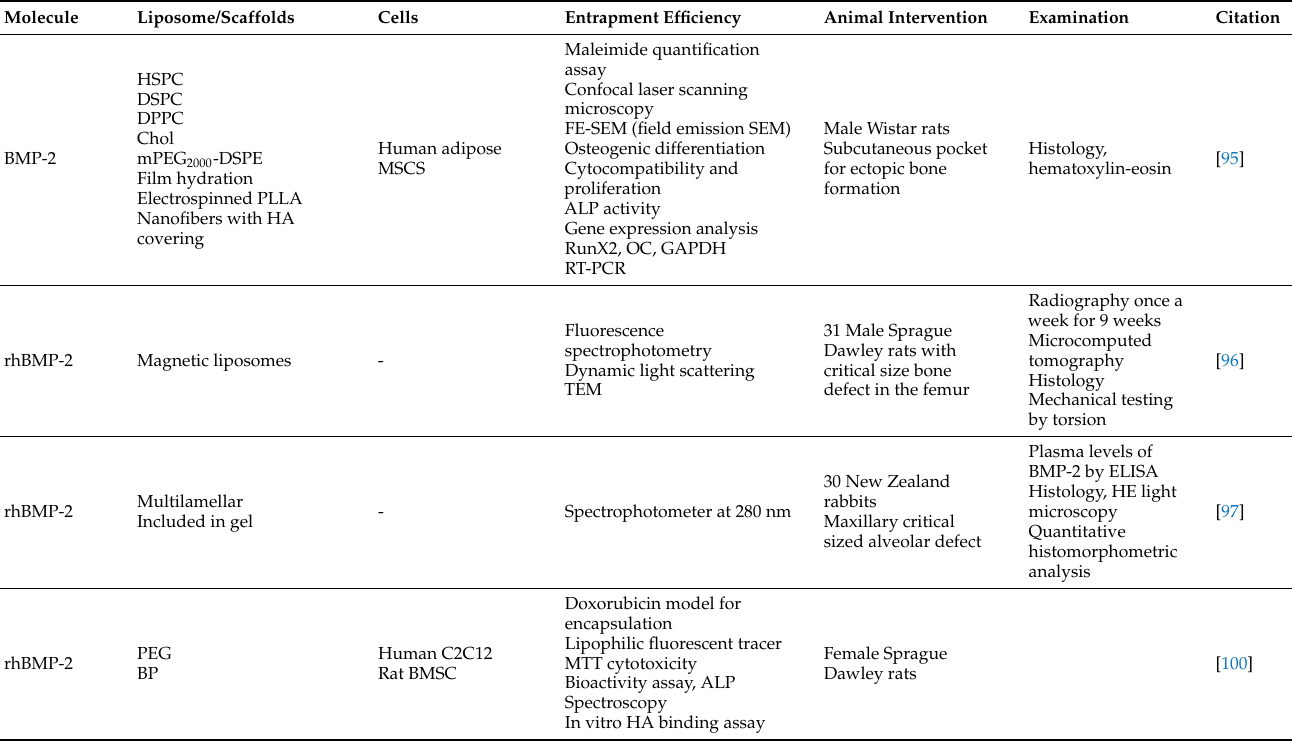
Table 1. Direct liposomal administration of